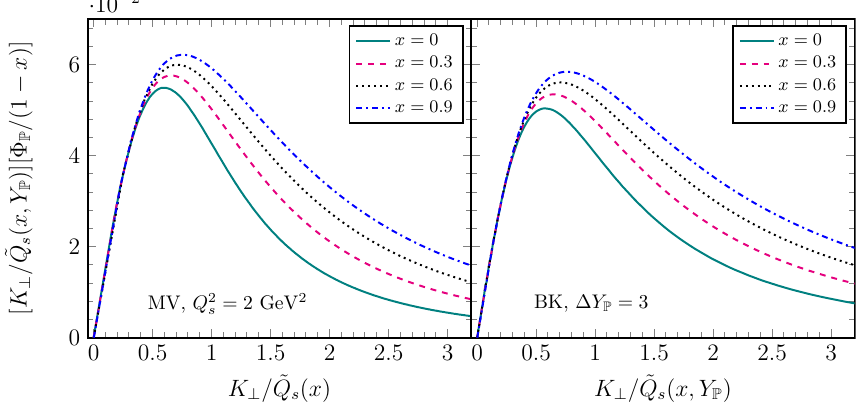
Figure 7 . The gluon occupation number for the Pomeron as obtained from eqs. (4.18) and (4.26), scaled with [ K ⊥ / ˜ Q s ( x, Y )] / (1 − x ) and plotted as a function of K ⊥ / ˜ Q s ( x, Y P x and Y . Left panel: T g ( R ) is given by the MV model. Right panel: T g ( R, Y P the solution to the BK equation with the initial condition at ∆ Y MV